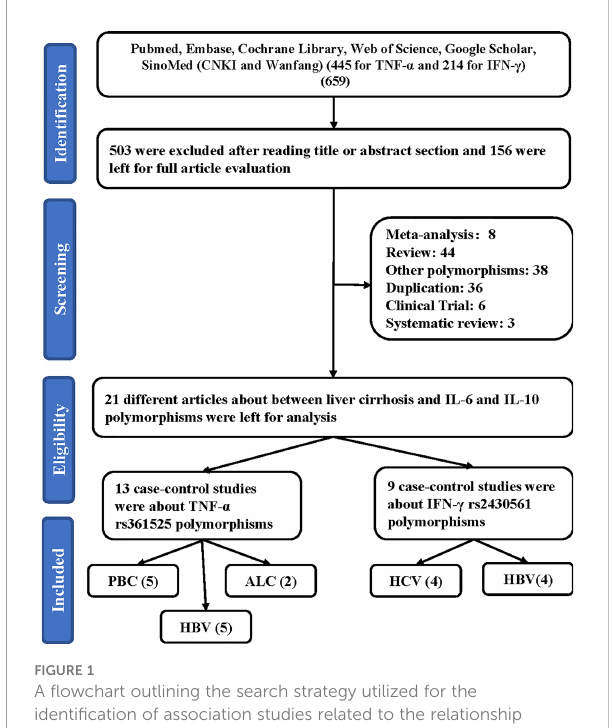
FIGURE 1 A fl owchart outlining the search strategy utilized for the identi fi cation of association studies related to the relationship between the TNF- a rs361525/ IFN- g rs2430561 polymorphisms and the risk of